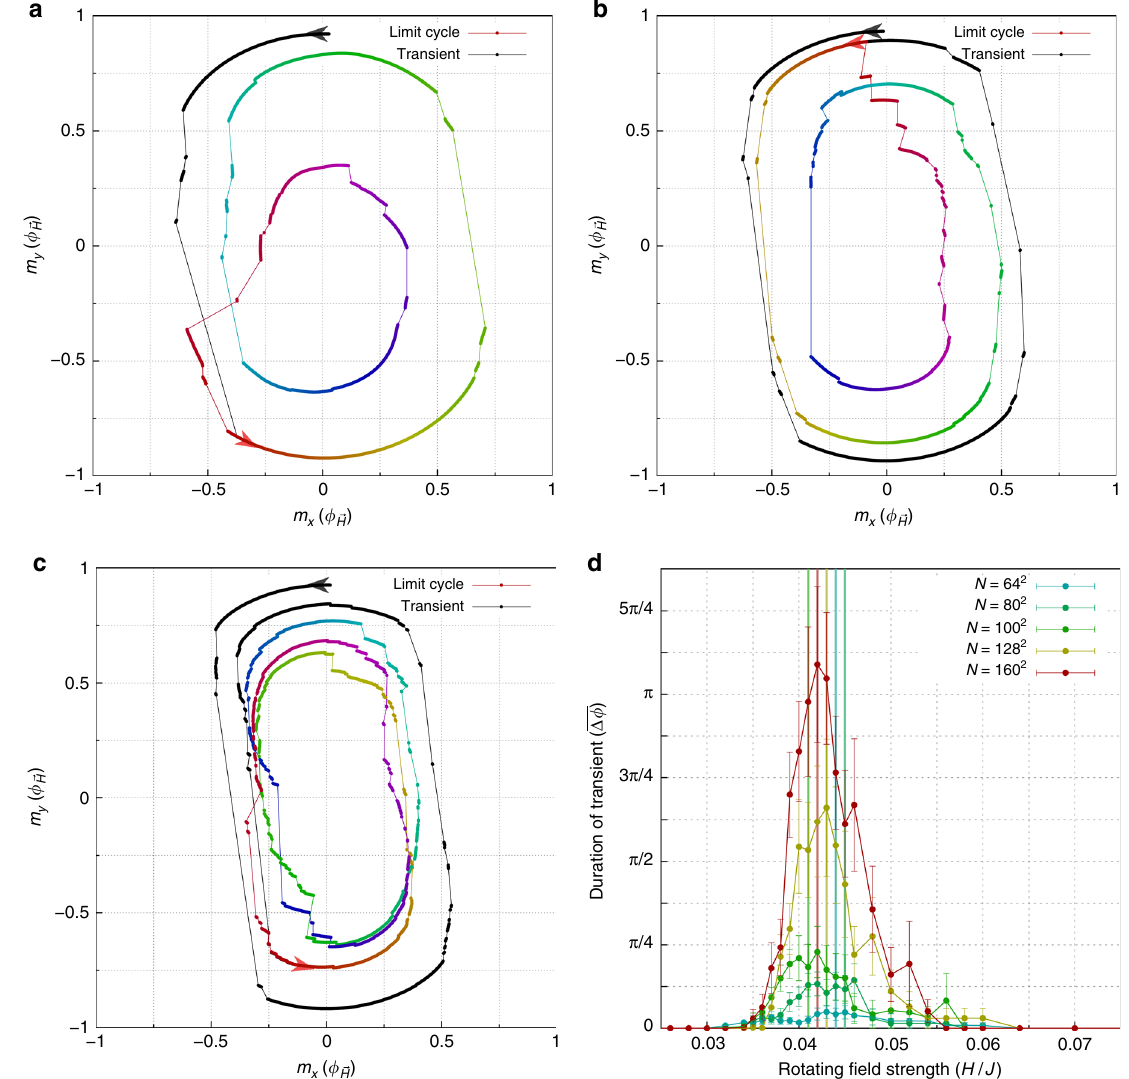
Fig. 3 Transient response and multiperiod limit cycles at T = 0 near the transition fi eld strength for disorder strength R x = 0.5 J . a – c show the initial transient response (black curves), followed by multiperiodic limit cycles (rainbow curves). a H = 0.058 J ; N = 64 × 64. Transient response and multiperiodic limit cycle for one disorder con fi guration at N = 64 2 . Here the transient response lasts roughly half a cycle before a period-2 limit cycle is established. b H = 0.048 J ; N = 100 × 100. Transient response and multiperiodic limit cycle for one disorder con fi guration at a larger system size N = 100 2 . Here the transient response lasts roughly one cycle before a period-2 limit cycle appears. c H = 0.046J; N = 160 × 160. Transient response and multiperiodic limit cycle for one disorder con fi guration at an even larger system size N = 160 2 . Here the transient response lasts almost 1.5 cycles before a period-3 limit cycle is established. d Statistics of transient response. The disorder-averaged duration of the transient response, as a function of H . The error bars are the standard deviation over the disorder average as described in the text. The mean of the transient distribution function for each system size is marked by a vertical line of the corresponding The vertical blue bars mark the mean of the distributions in i i Fig. 5a – e, h H . In Fig. 5f, we plot h H vs. 1/ N on a log – log lc lc N N i plot, in order to determine the limiting value h H . Fits of lc N !1 the fi nite size scaling in Fig. 5f for all system sizes, the four largest system sizes, and the three largest system sizes yield a consistent i within error bars. The average of these three value for h H lc N !1 i ¼ ð 0 : 0434 ± 0 : 0020 Þ J . methods yields h H lc N !1 We fi nd that, at small system size, multiperiod behavior is rare. However, as the system size is increased, and the disorder con- fi gurations can become correspondingly more rich, the likelihood of multiperiod behavior increases. In Fig. 6a, we plot the max- imum observed period of a limit cycle vs. 1/ N . The maximum period increases with increasing system size, in a manner con- sistent with diverging period in the thermodynamic limit.